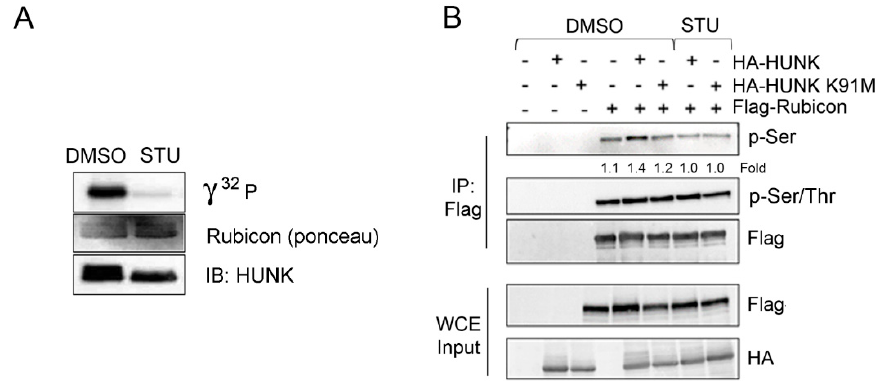
Figure 3. HUNK phosphorylates Rubicon ( A ) In vitro HUNK kinase assay using recombinant Rubicon (aa 1-375) as substrate. HUNK was preincubated with either DMSO or the HUNK inhibitor staurosporine (STU, 5 µM). ( B ) HA-HUNK or HA-K91M HUNK and Flag-Rubicon were expressed in 293T cells. Flag-Rubicon was immunoprecipitated using anti-Flag affinity resin and isolated protein was immunoblotted using anti-pSer and anti-pSer/Thr antibodies.